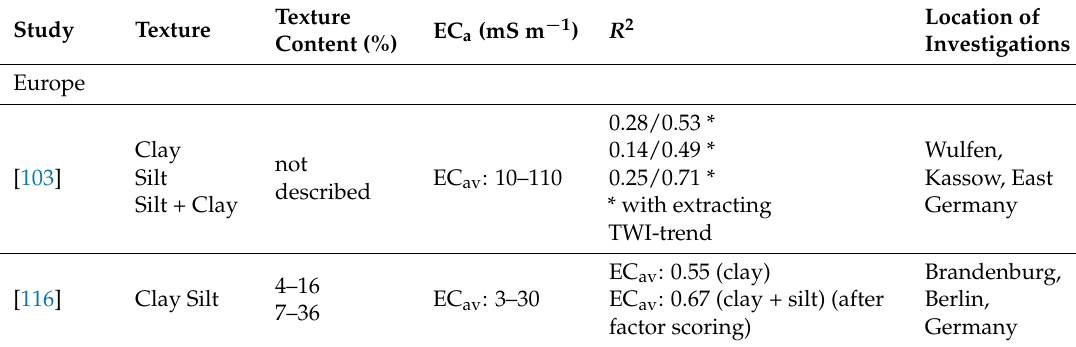
Table 2. References indicating relationships between EM38-EC a and soil